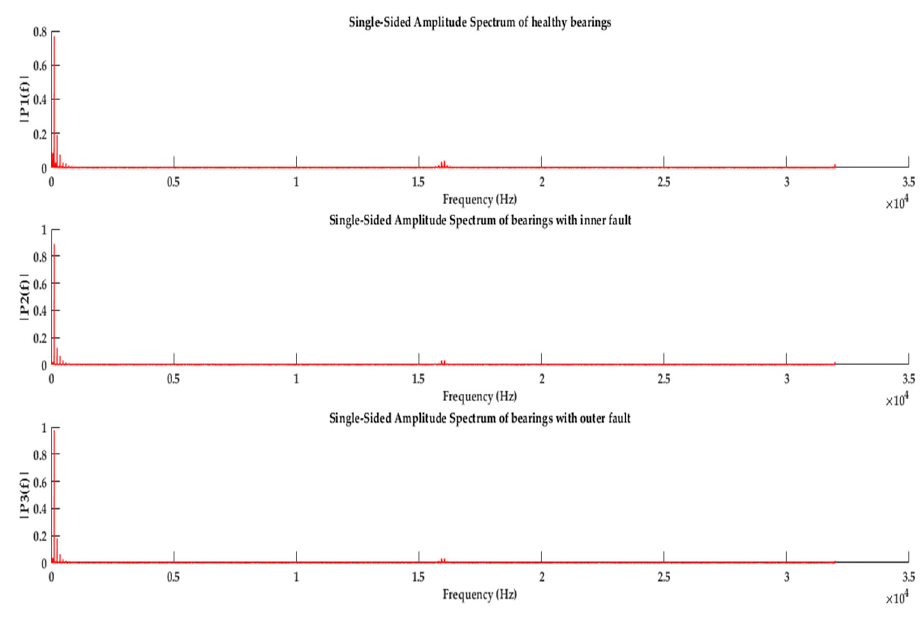
Figure 4. Frequency spectrum from MCS for healthy bearing, inner ring damage, and outer ring damage.